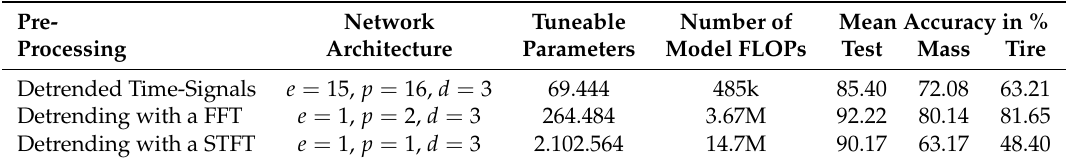
Table 3. Comparison of best performing network